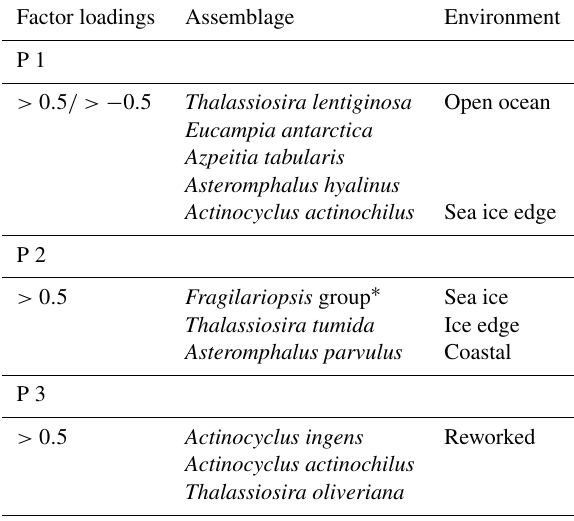
Table 3. Species assemblages (PC 1–PC 3) according to Q mode principal component analysis (further information can be found in Table S2).